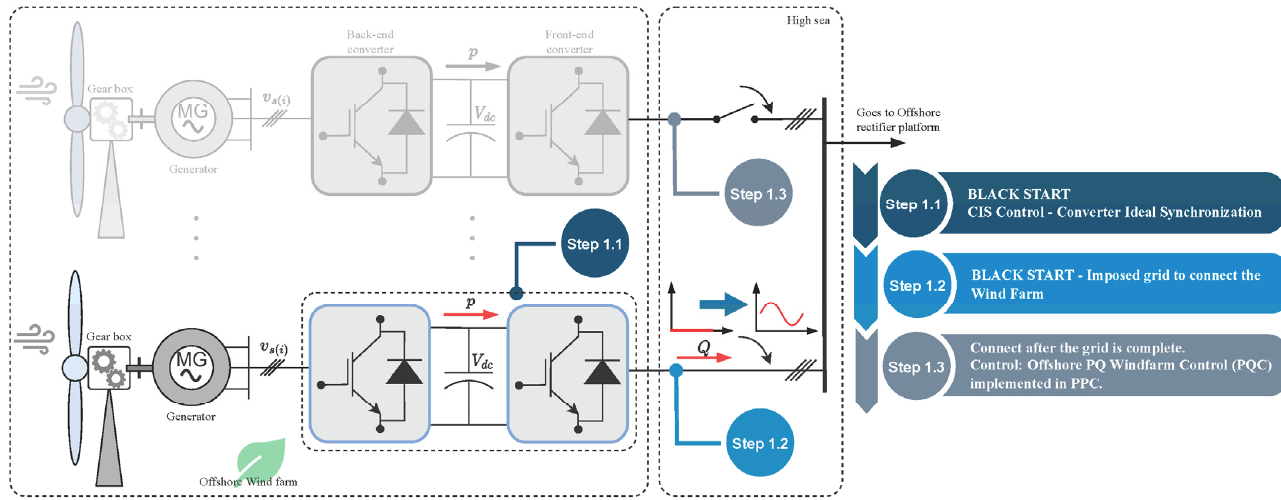
Figure 3. Control flow chart for the black start to start the AC grid voltage system.